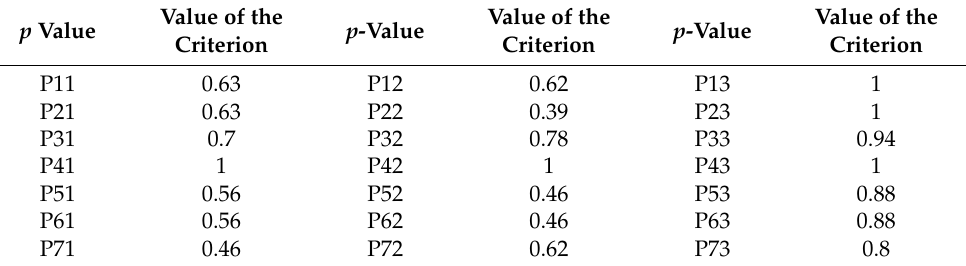
Table 4. Normalized decision matrix statistical variation method.